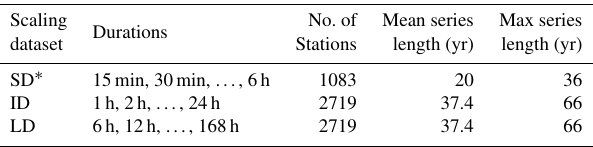
Table 2. Final datasets used in scaling analysis and corresponding AMS